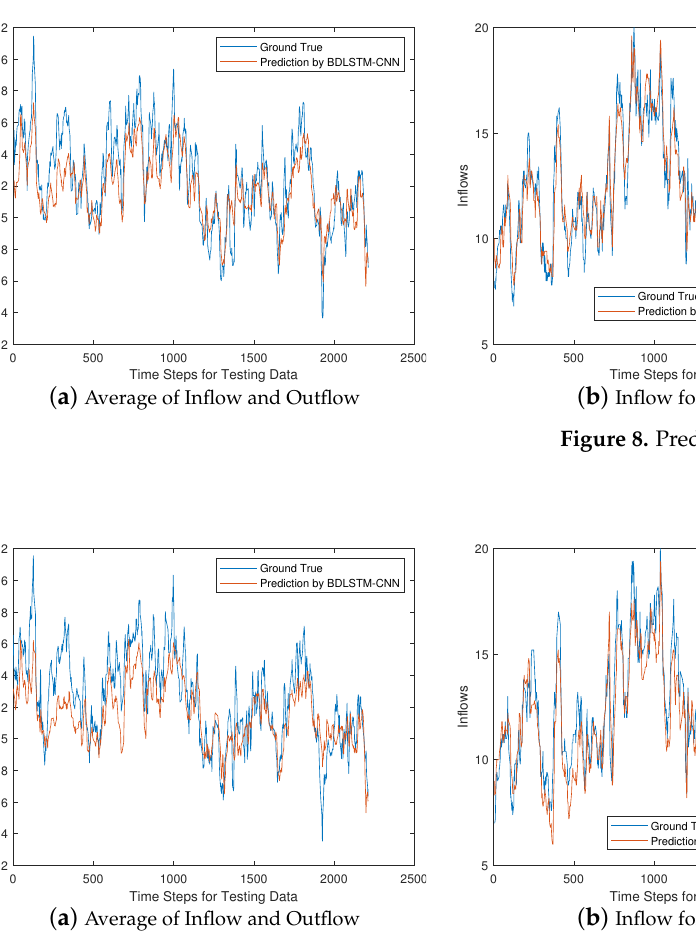
Figure 9. Prediction for Y t = X t + 2